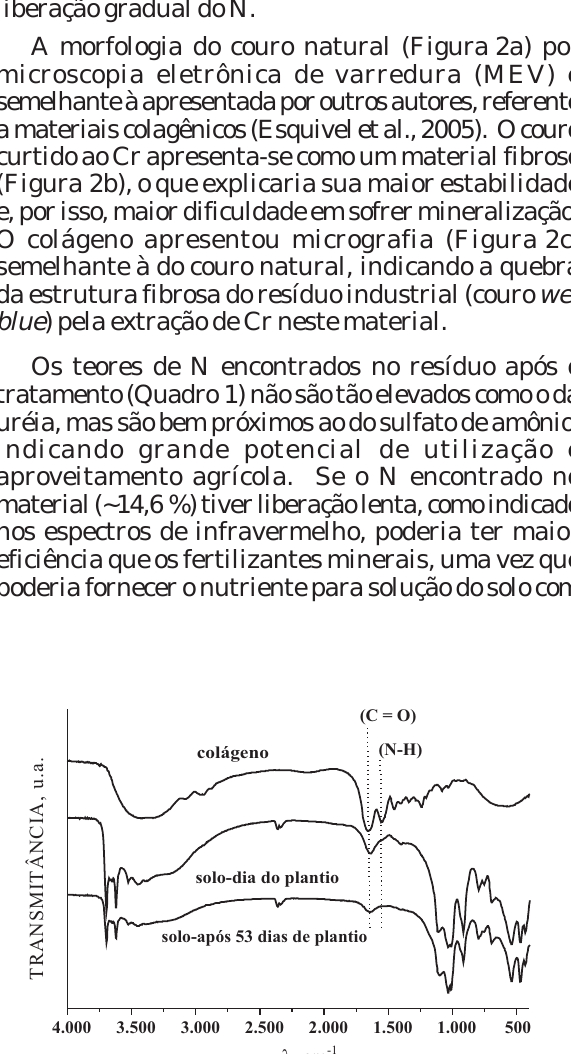
Figura 2. Micrografias dos resíduos de couro: (a) couro natural, (b) couro wet blue e (c) resíduo tratado (colágeno).